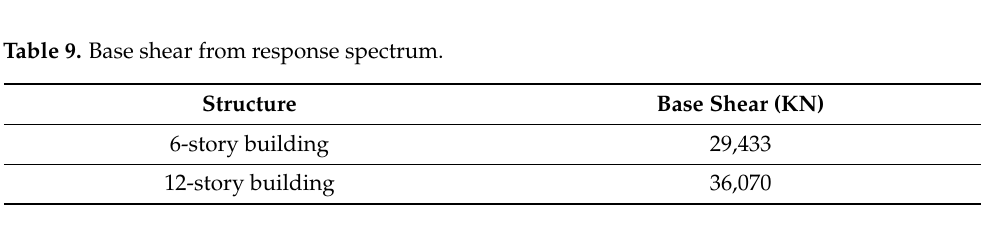
Table 10. Base shear obtained from the time-history